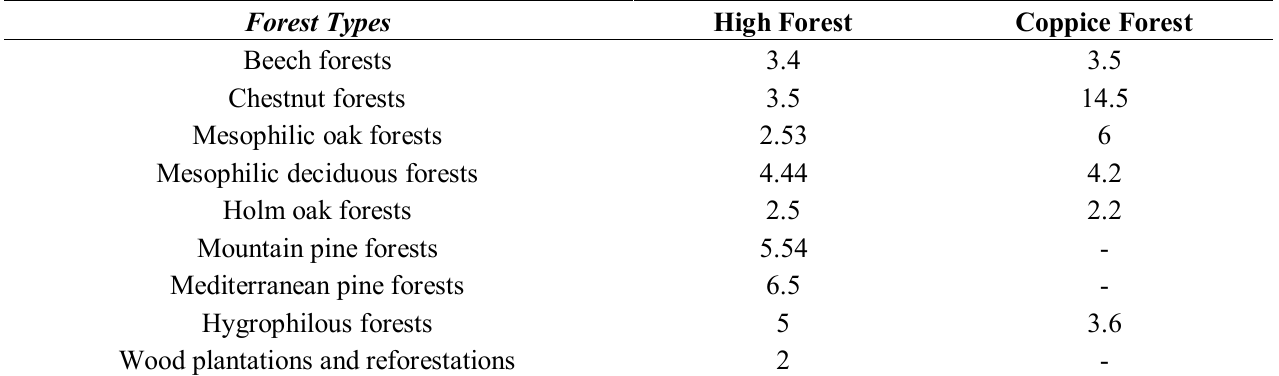
Table 1. Mean increments by forest type (m 3 ha −1 year −1 ).